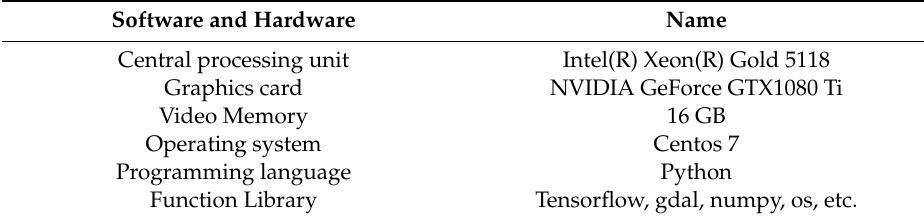
Table 2. Precision comparison of FCN-8s, FCN-16s, and FCN-32s. Structure